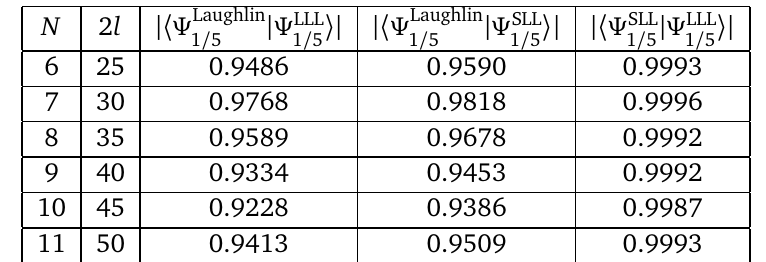
Table 1: Absolute value of the overlap of the exact Coulomb ground state at ν = 1 /